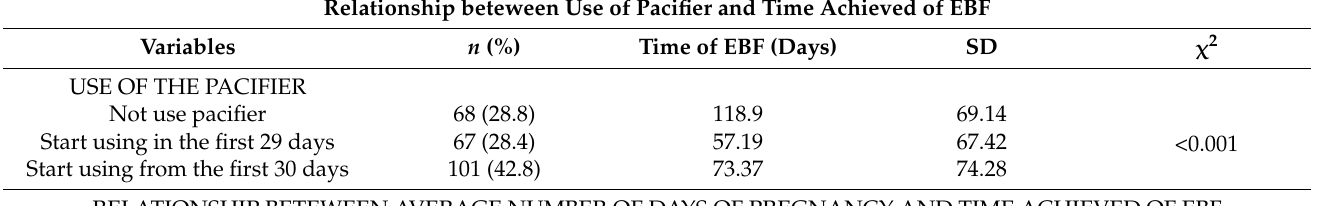
Table 2. Relationship between the other variables and the maintenance of exclusive breastfeeding for 6 months (women who practiced exclusive breastfeeding for some time during the 6